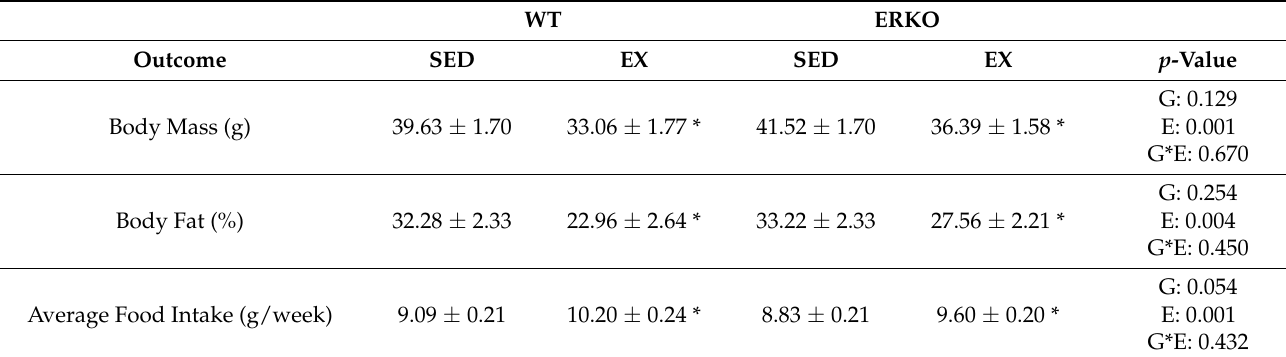
Table 1. Metabolic